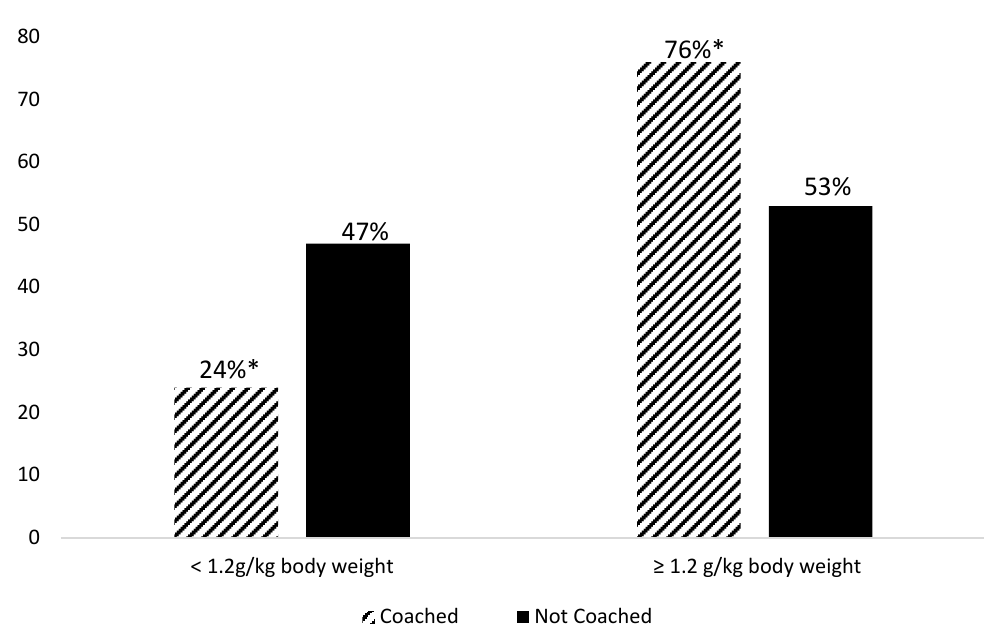
Figure 2. Percentage of participants meeting the three-meal protein prescription by group. * Significantly different ( p = 0.04) coached versus not coached.